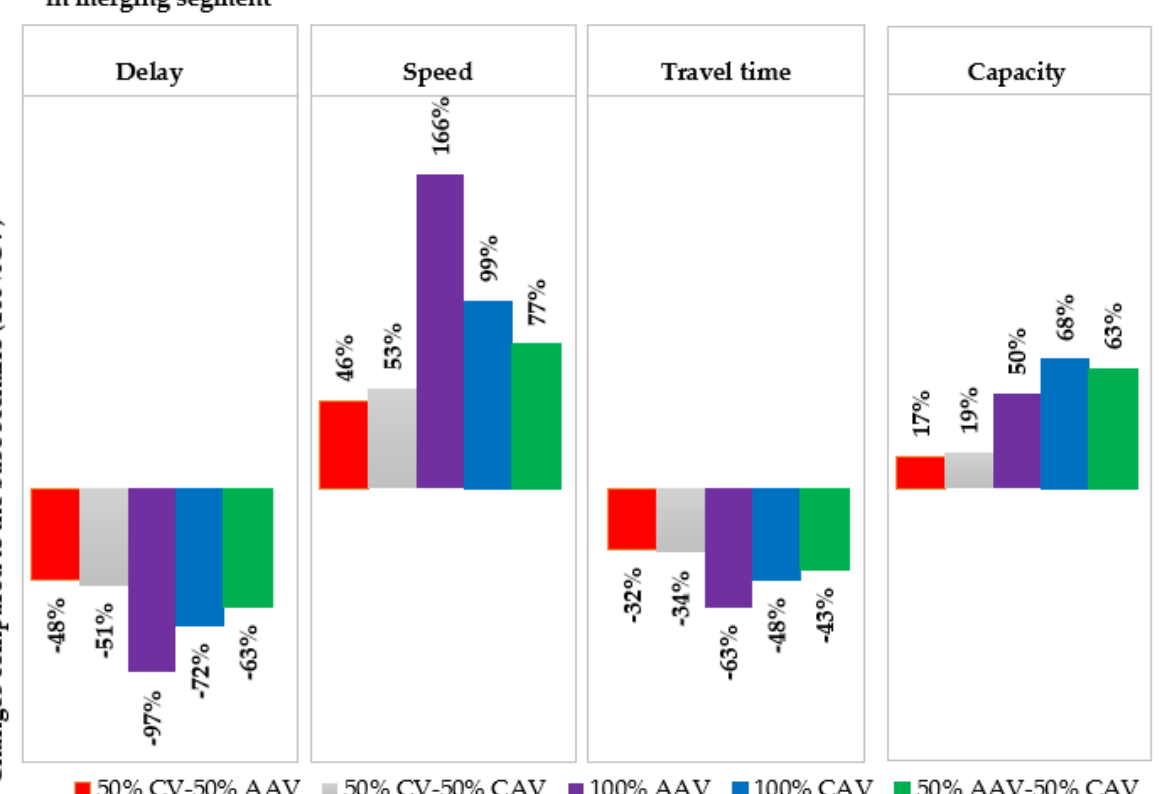
Figure 7. Simulation results of traffic flow parameters compared to the base scenario (100% CV): merging segment.